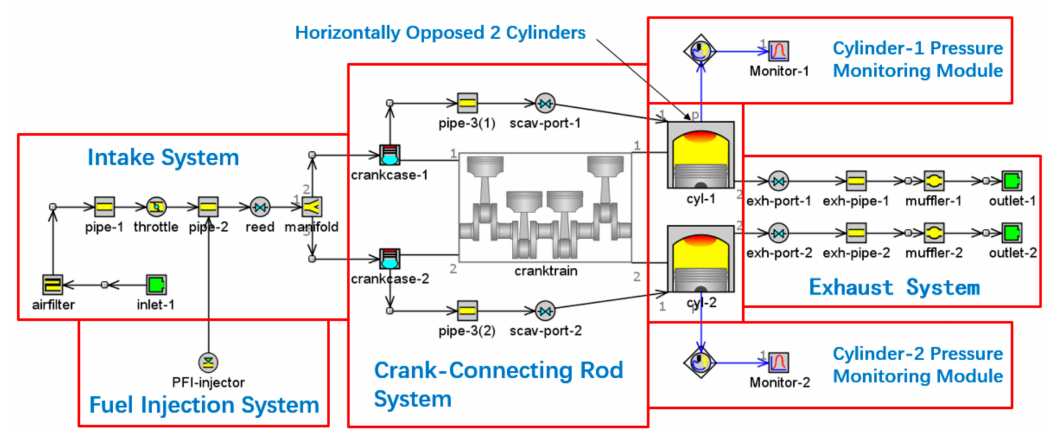
Figure 18. The layout of the integrated simulation platform in GT-ISE (initial prototype